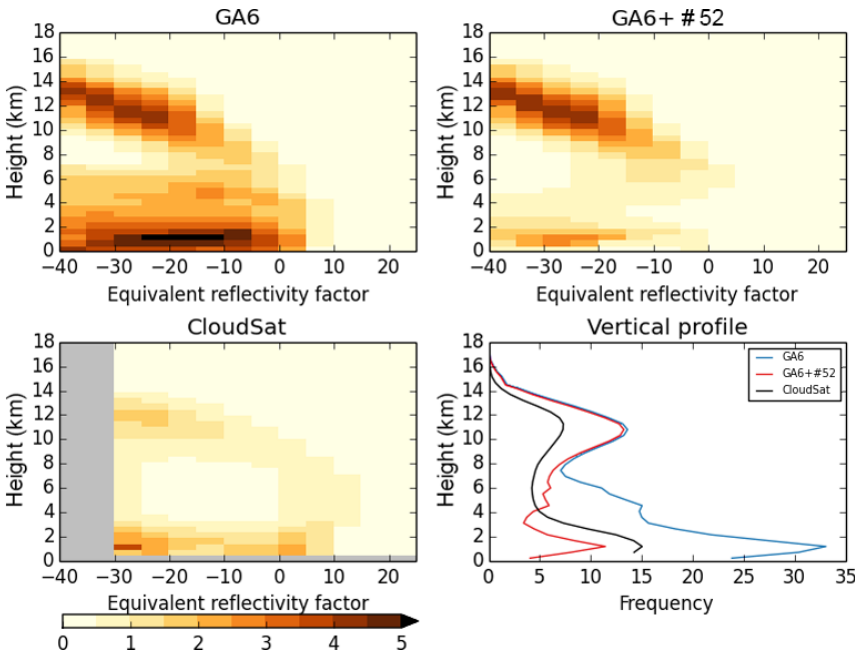
Figure 2. Histograms of height vs. 94GHz radar reflectivity over a trade cumulus region (130–160 ◦ W, 0–20 ◦ S), showing climatologies of CloudSat observations and simulated CloudSat data from 20-year N96 atmosphere/land-only climate simulations using GA6.0 and GA6.0 plus the new warm microphysics